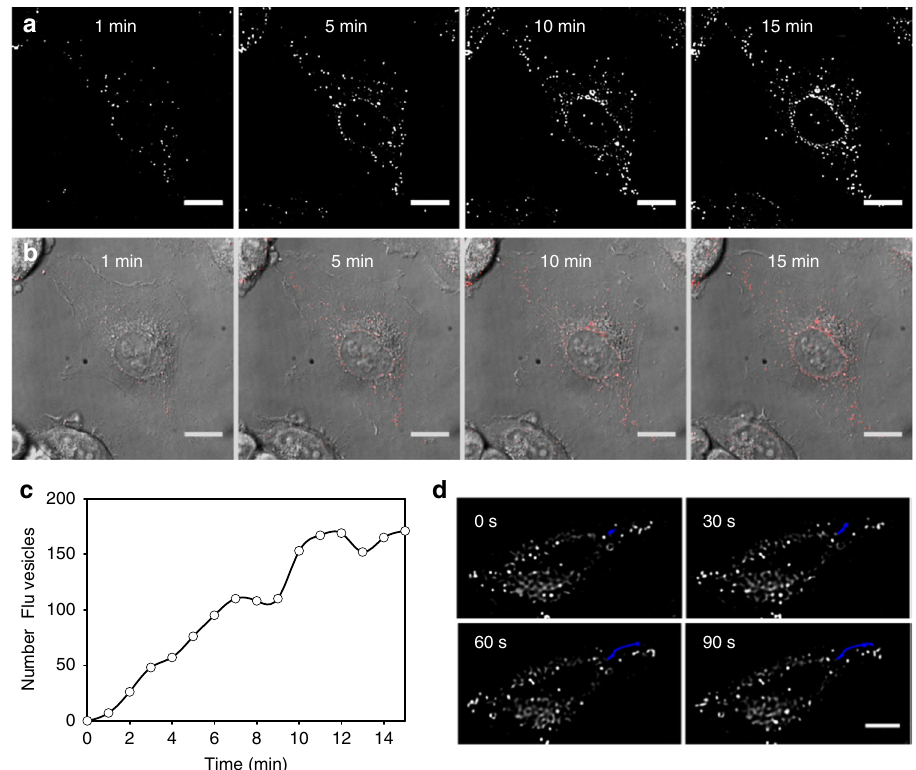
Fig. 9 Real-time live HeLa-Kyoto cell imaging of uptake, turning on and traf fi cking of NP 1 -P 188 . a NIR- fl uorescence (shown in white) from a single cell over 15 min following treatment with NP 1 -P 188 (Supplementary Movie 14). b Overlay of NIR- fl uorescence (shown in red) and DIC images from a single cell over 15 min following treatment with NP 1 -P 188 (Supplementary Movie 15). Scale bars = 20 μ m. See Supplementary Fig. 15 and Supplementary Movies 17, 18 for a larger fi eld of view of this experiment. See Supplementary Fig. 16 and Supplementary Movies 19, 20 for images from an additional independent experiments. c Plot of increasing number of intracellular fl uorescent vesicles over time following treatment of HeLa-Kyoto cells with NP 1 -P 188 . Data acquired from the fi eld of view shown in Fig. 9a. d Translocation of a single fl uorescent vesicle in a HeLa-Kyoto cell over a 90 s time period (20 min after addition of NP 1 -P 188 ). Track of vesicle shown in blue. Scale bar = 20 μ